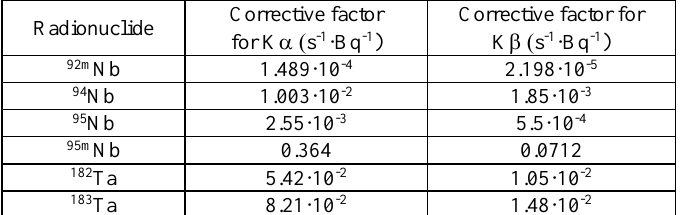
Table 2. Correction factors for fluorescence induced by gamma-emitting